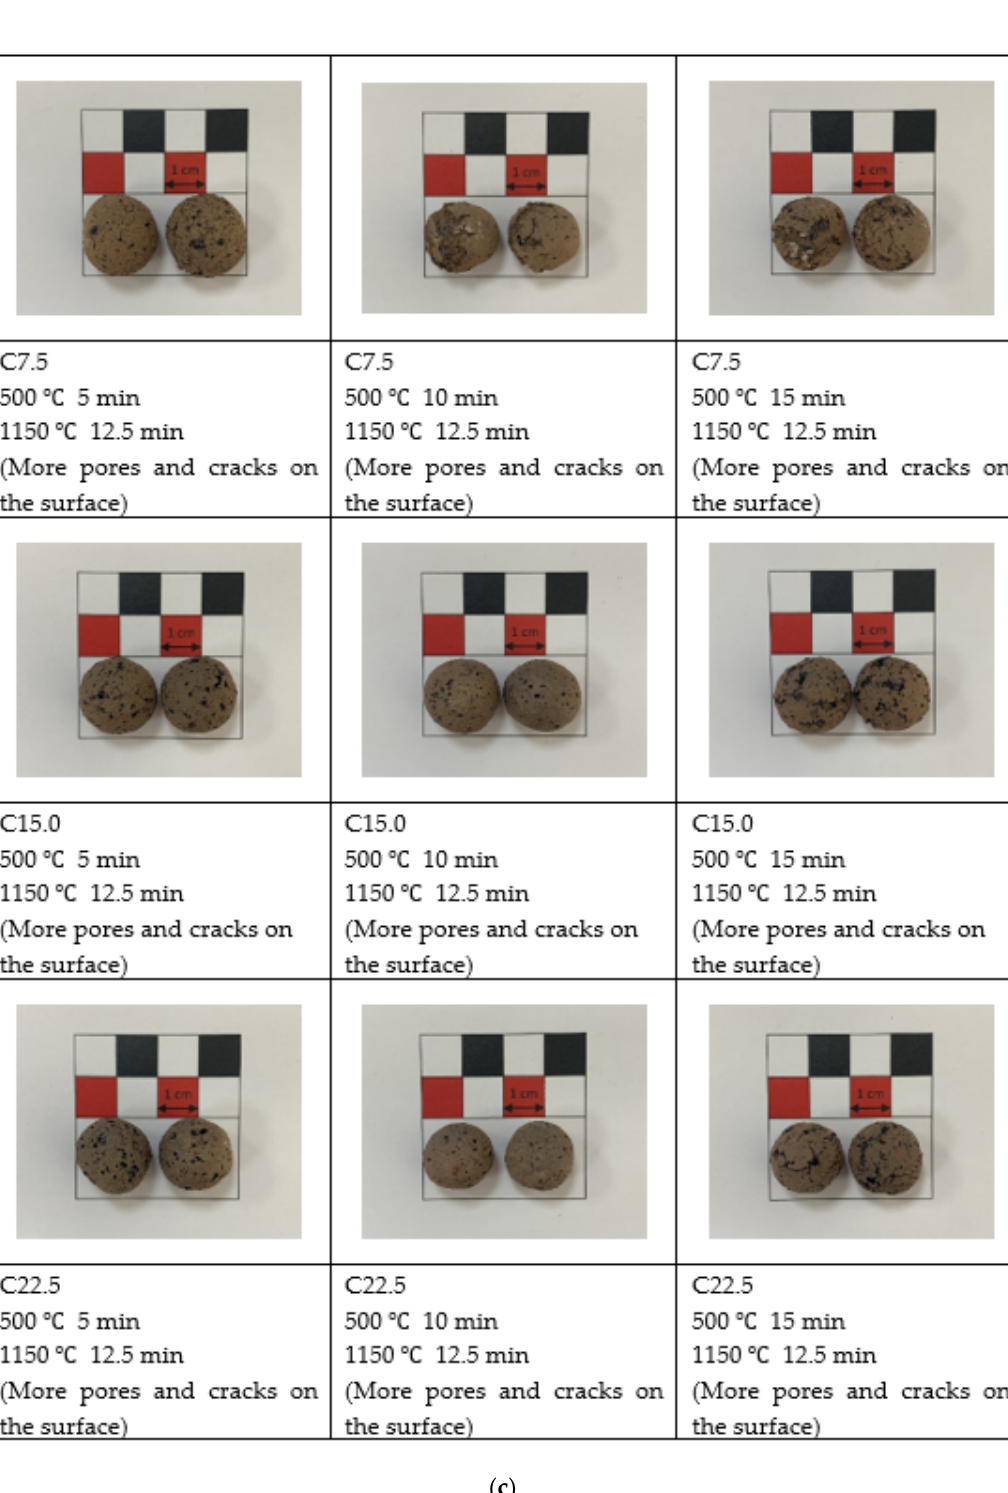
Figure 5. Stage II sintering of lightweight aggregates for ( a ) Industrial Sludge A, ( b ) Industrial Sludge B, and ( c ) Industrial Sludge C.